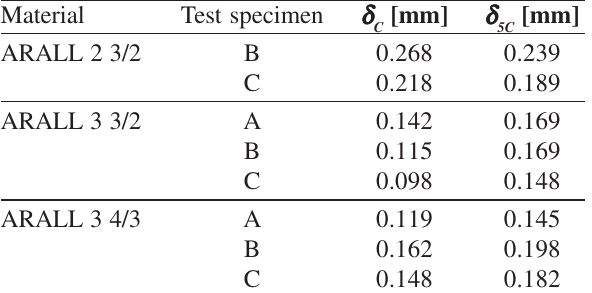
Table 2. Critical values of the ASTM CTOD ( δ ) and SCHWALBE CTOD ( δ ). 5